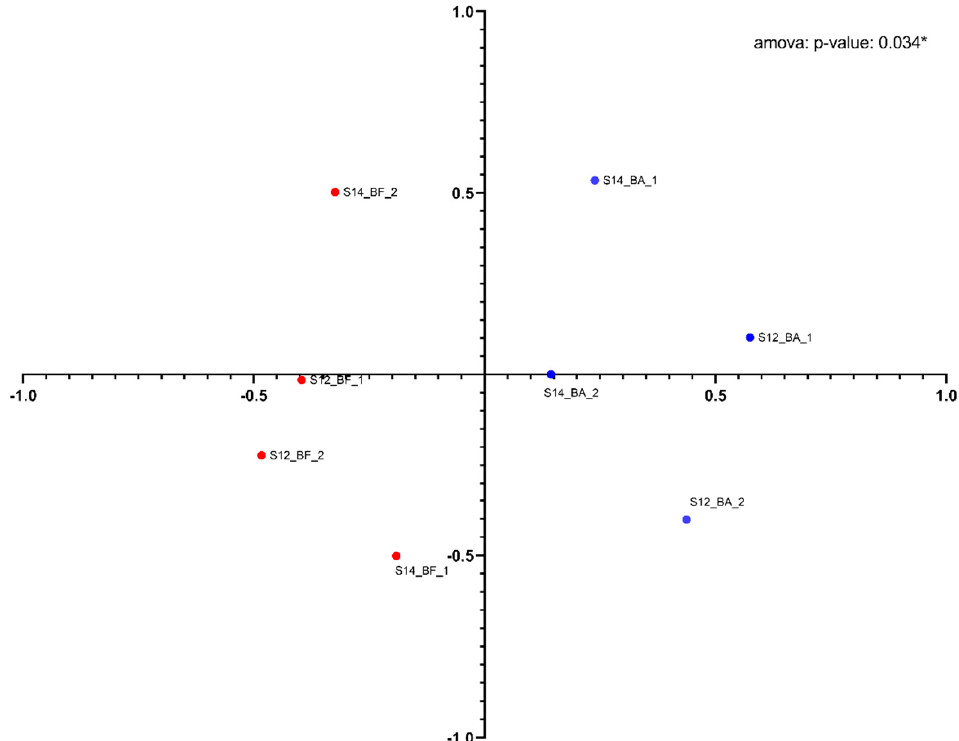
Figure 5. Nonmetric multidimensional scaling (NMDS) distance matrix analysis between the up- stream samples (red dots) and the downstream samples (blue dots) based on Jaccard distances. Each dot is labeled with the following code: Sampling date (S12: 16 June; S14: 30 June, sample type (BA: before the bioatomizer, upstream; BF: after the biofilter, downstream), and the biofilter number (1: channel 1; 2: channel 2).